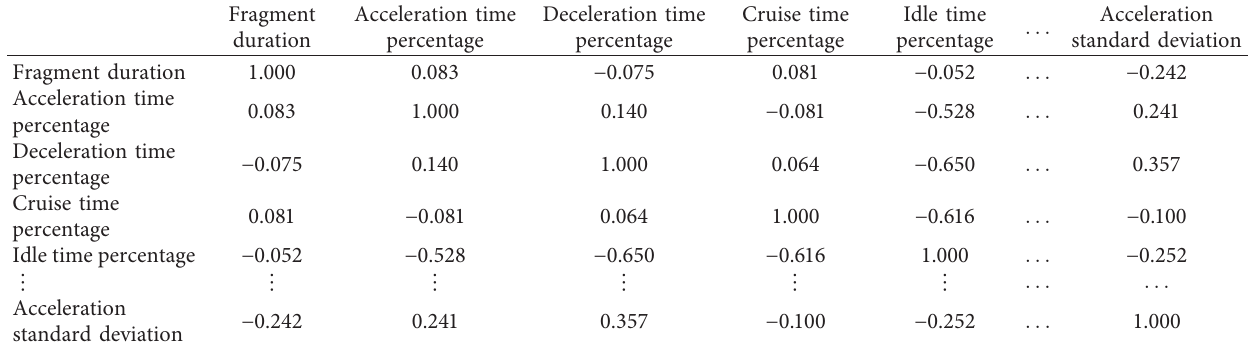
Table 3: Correlation among feature parameters.